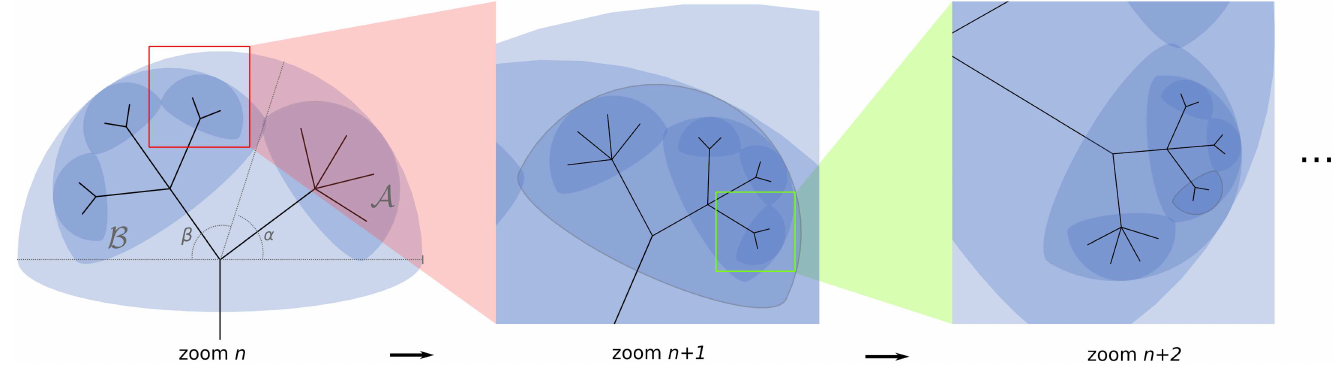
Fig 1. Three successive zoom levels in Lifemap illustrating the half-circle representation employed. Each clade is represented by a half-circle whose size dependson the relative numberof species in the clade as comparedto its sister clades at a given level. Note that these proportions are not respectedat the tree root where the three superkingdoms are arbitrarilygiven the same size. Computation of the size of each half-circle is based on the angle they are associatedwith ( α and β on the first panel): if n A and n B are the numberof species in clades A and B, respectively,the anglesin degreesare computed as follows: a ¼ 180 (cid:2) very small and very large groups. At every level, the half-circles(clades) are randomlydistributedwithin their parentalhalf-circle.